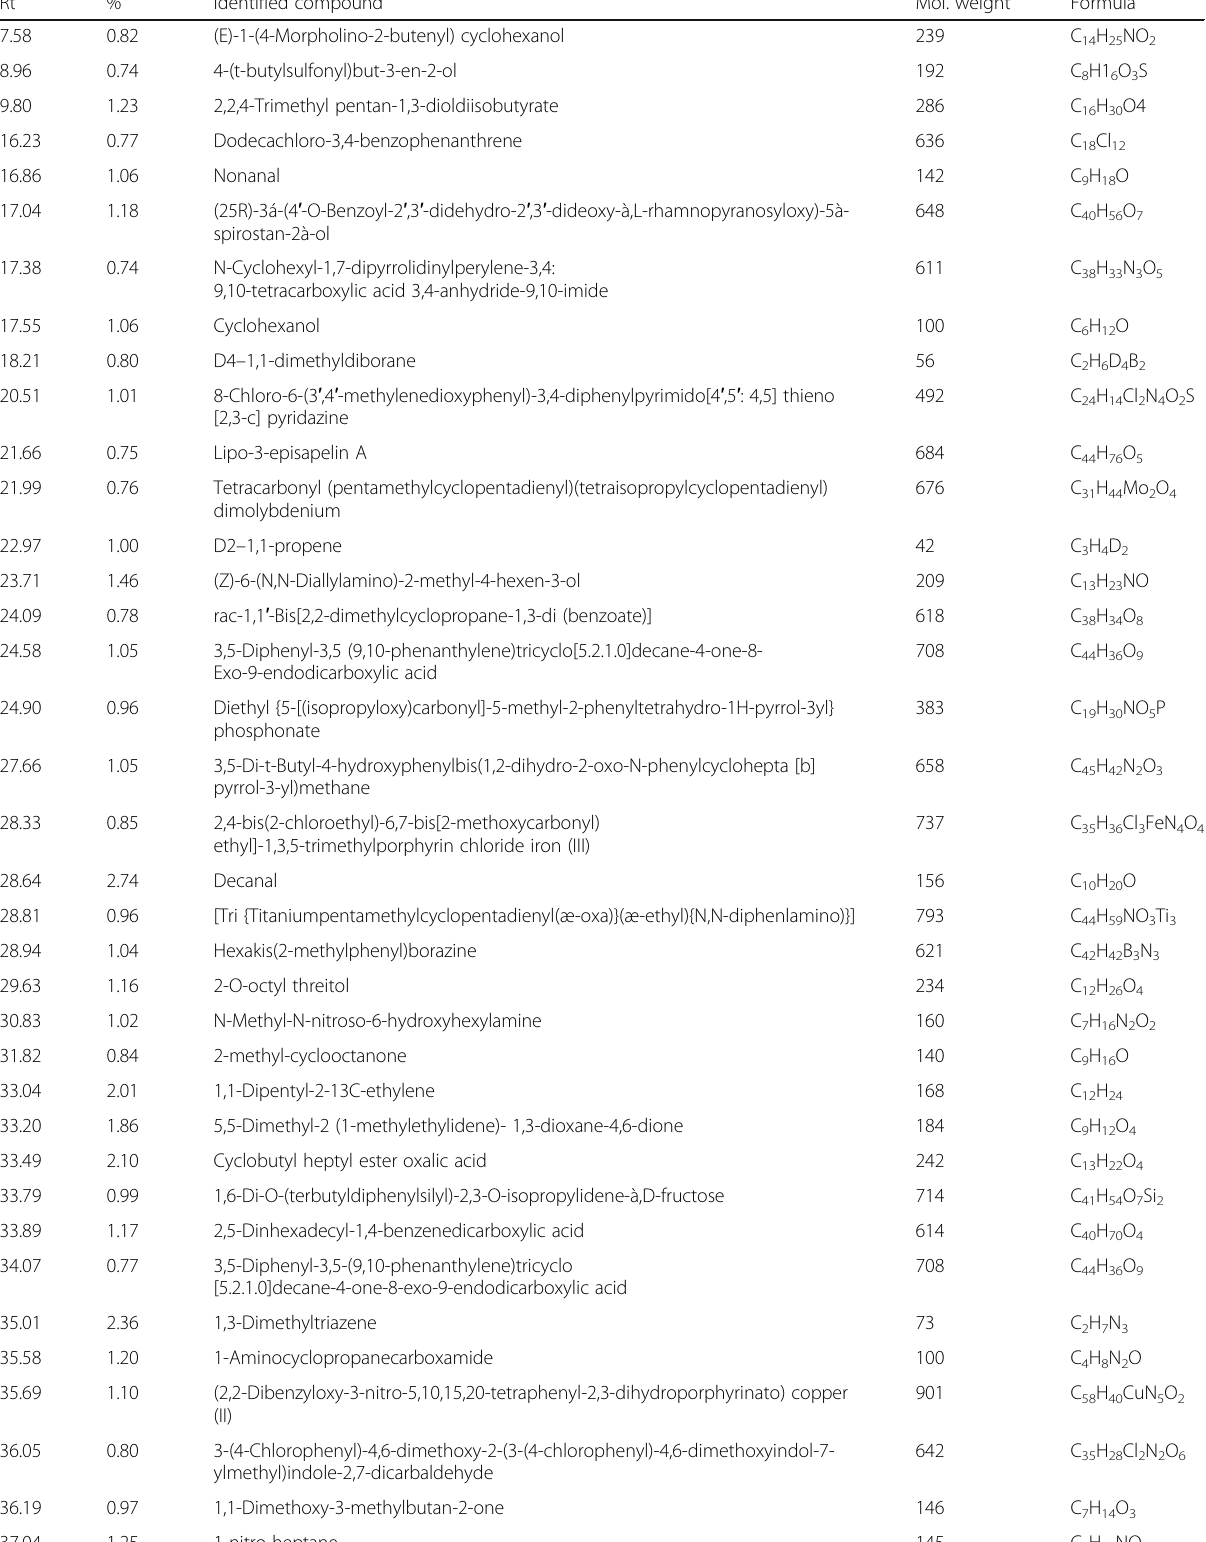
Table 4 GC/MS analysis of the M. oleifera leaves extract after incorporating Ag-NPs Rt % Identified compound Mol.